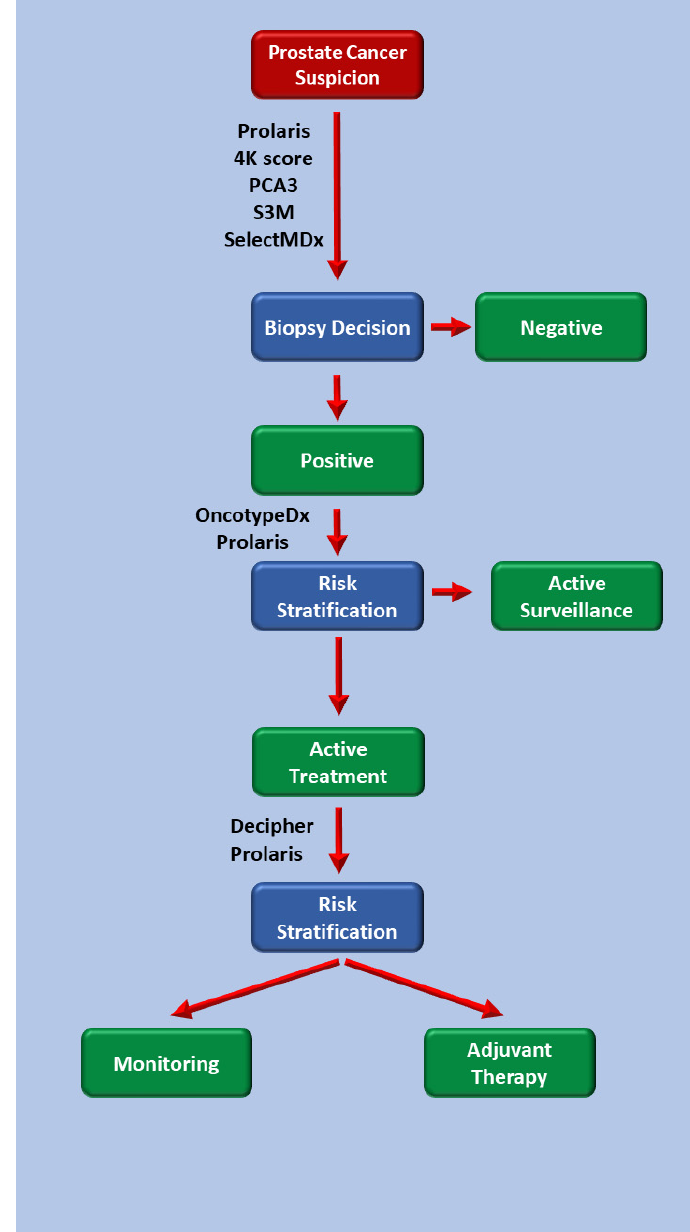
Figure 1. Algorithm describing the utility of prostate cancer biomarkers and risk assessment tools in clinical practice.